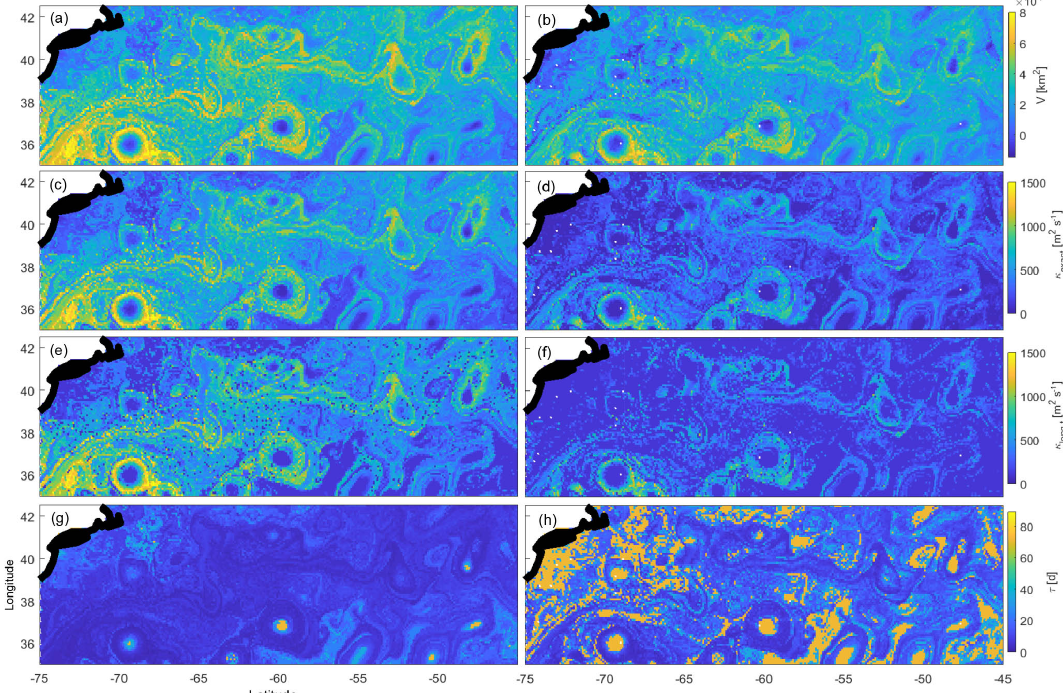
Figure 4. Encounter volume (a, b) , exact diffusivity (c, d) , long-time diffusivity (e, f) and diffusive timescale (g, h) for the full flow (a, c, e, g) and for the eddy component of the flow (b, d, f, h) . White shows land and the thick black curve shows the coastline. The encounter volume was computed on 11 January 2015 over 90 days with an encounter radius of